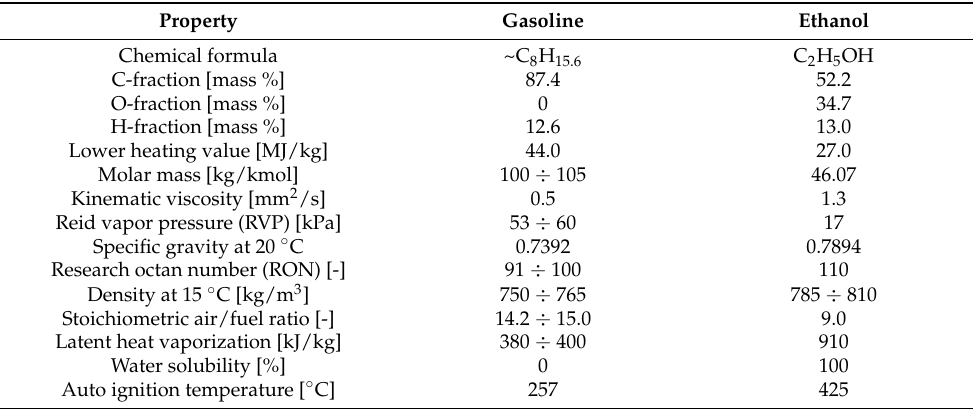
Table 1. Physicochemical characteristics of gasoline and ethanol